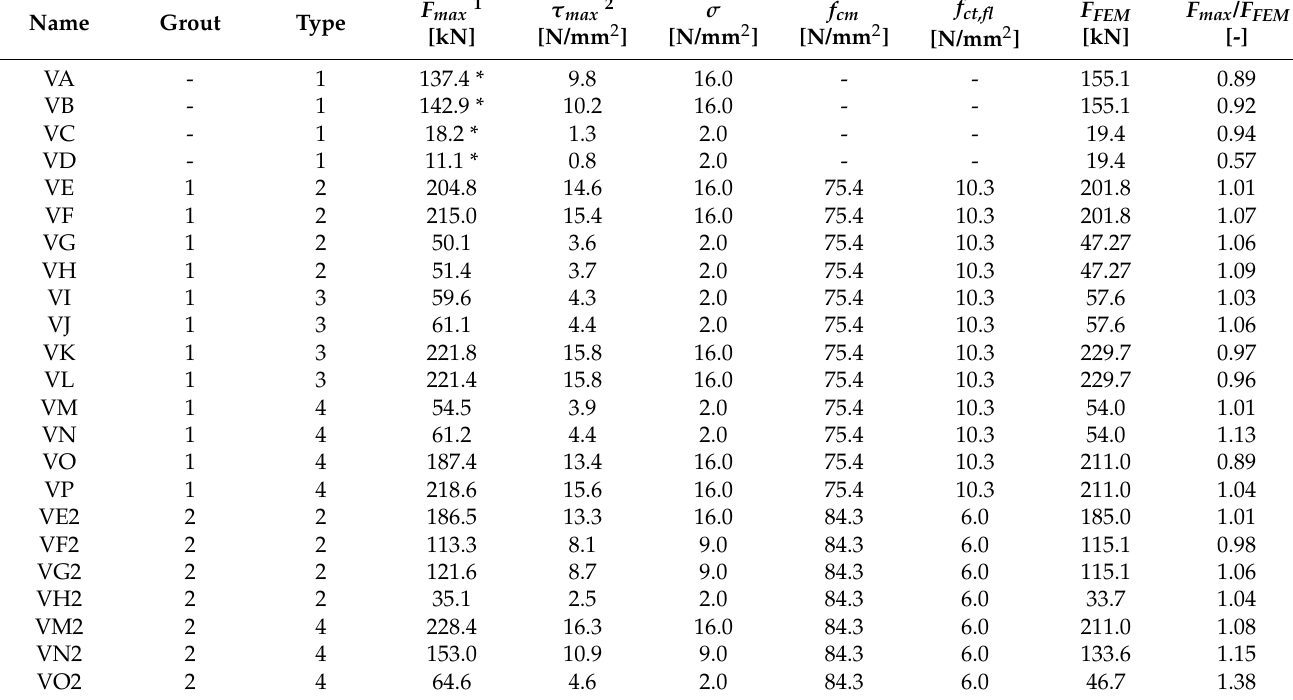
Table 7. Test results and comparison to FEM